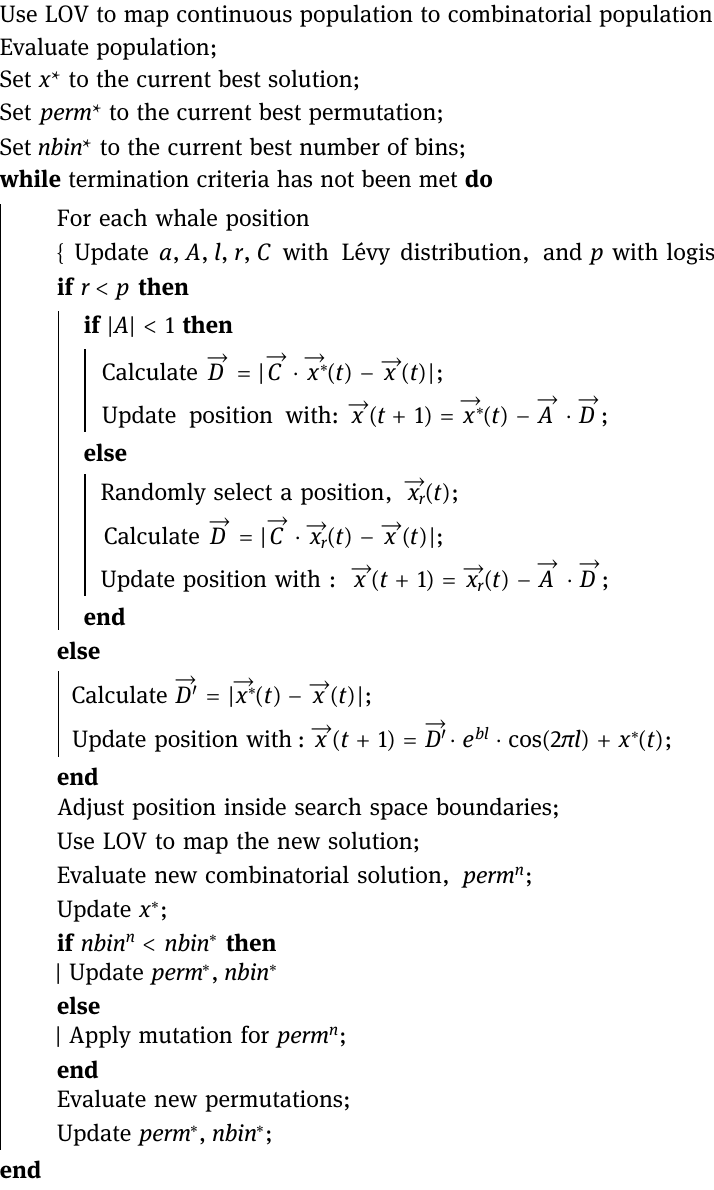
Algorithm 3 : Pseudocode of improved Lévy - based whale optimization algorithm Generate the initial